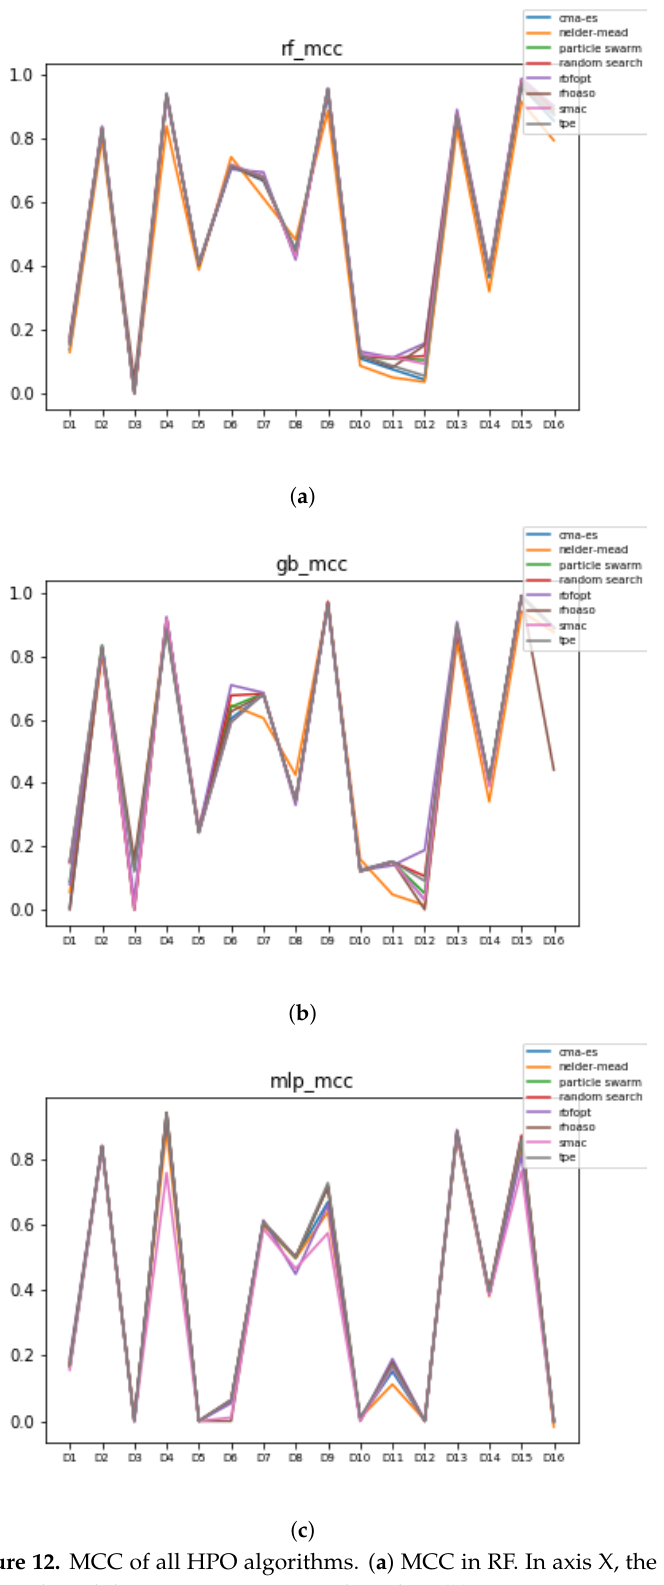
Figure 12. MCC of all HPO algorithms. ( a ) MCC in RF. In axis X, the dataset. In axis Y, the MCC obtained. Each line represents a HPO algorithm. ( b ) MCC in GB. In axis X, the dataset. In axis Y, the MCC obtained. Each line represents a HPO algorithm. ( c ) MCC in MLP. In axis X, the dataset. In axis Y, the MCC obtained. Each line represents a HPO